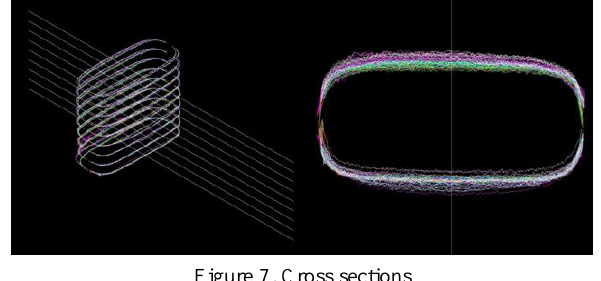
Figure 7. Cross sections